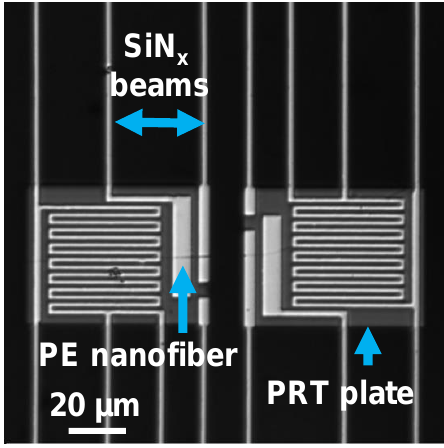
Figure 10. Optical image of a UHWMPE nanofiber sample mounted on the thermal device.